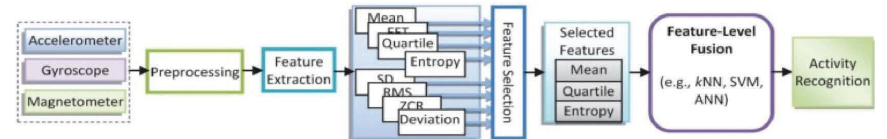
Figure 7: Calibration process